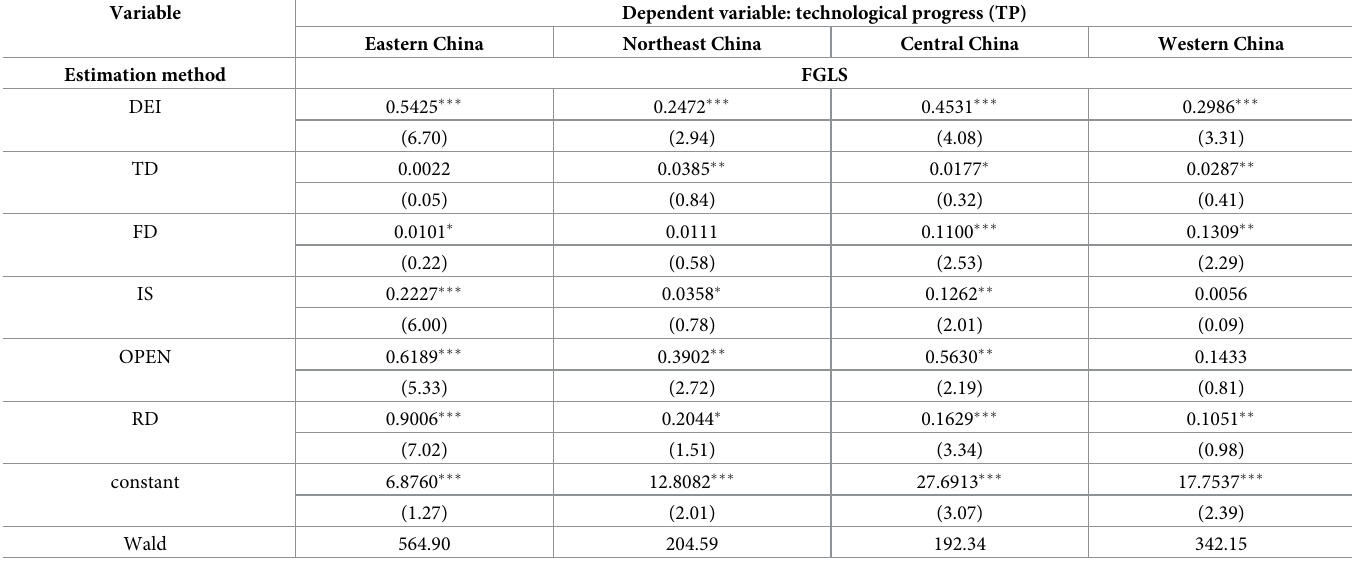
Table 10. The regression results of the sub-regional digital economy in promoting technological progress. Variable Dependent variable: technological progress (TP) Eastern China Estimation